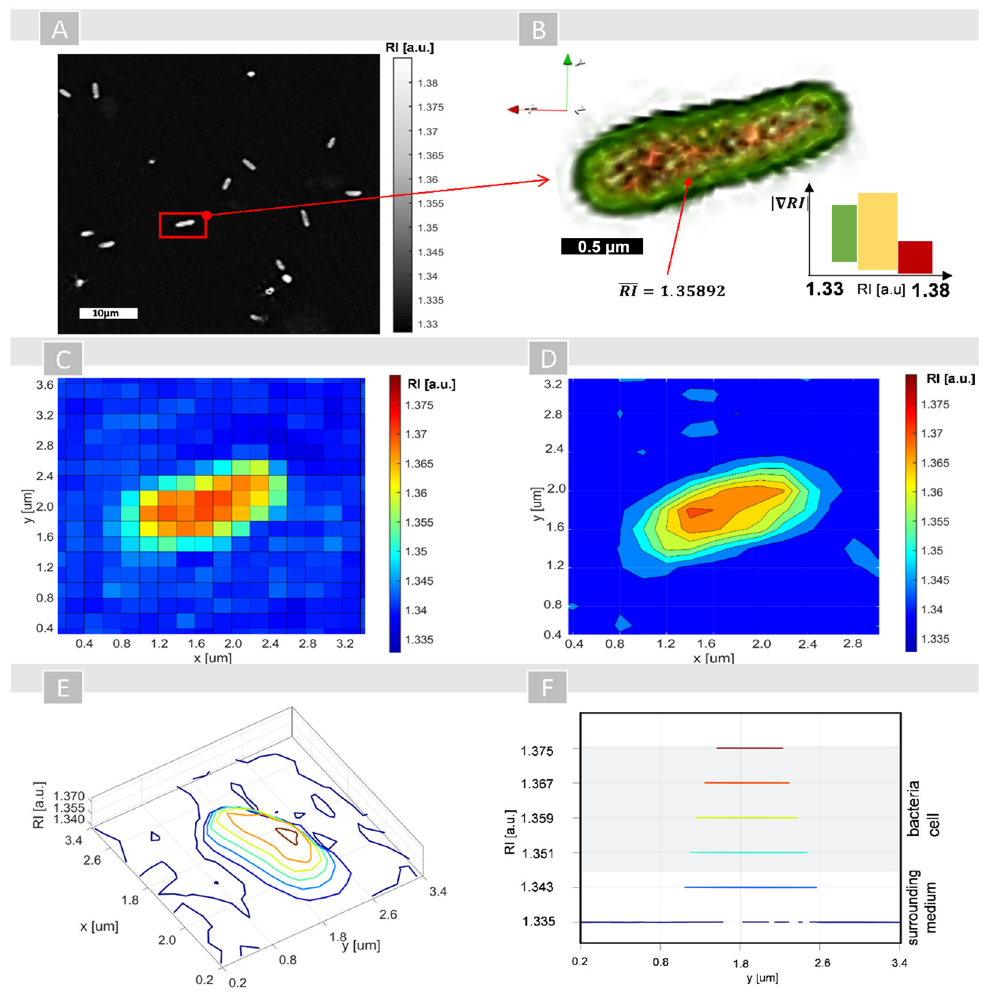
Figure 2. The exemplary results for E. coli cell on AVC material (non-photoactive): ( A ) reconstructed 2D-RI map (raw-data) with E. coli cells on the surface of AVC material; ( B ) 3D rendered and digitally stained single cell; ( C ) averaged 3D-RI distribution of single cell from all 2D-RI maps (slices) on which the cells were present; ( D ) distribution of averaged 3D-RI isolines; ( E ) pseudo-3D representation of averaged RI distribution; ( F ) cross-section of the isolines for different averaged 3D-RI values corresponding to the region occupied by a single cell.